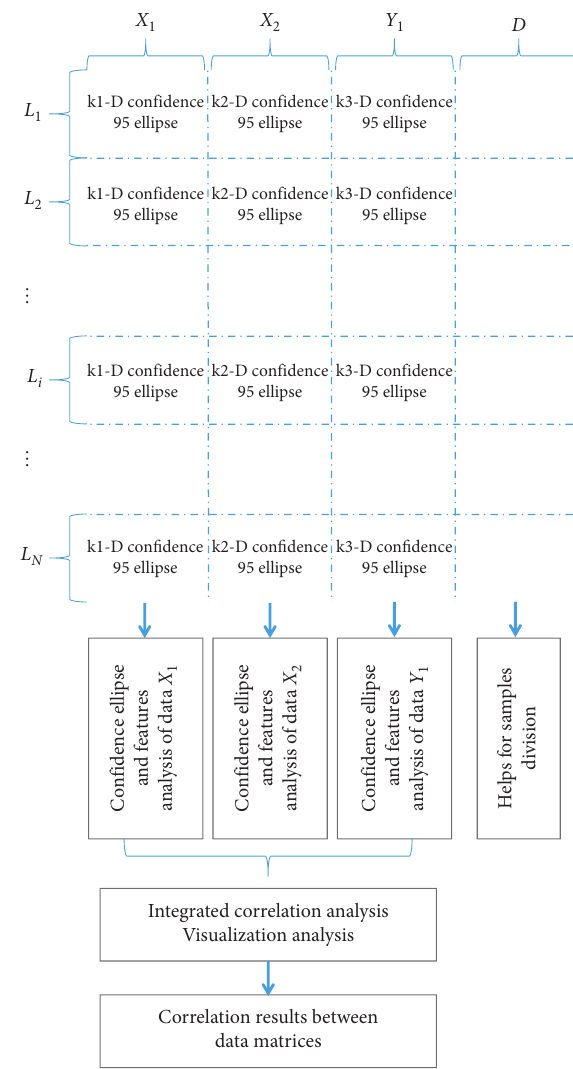
Figure 4: The specific scheme of the proposed method with the help of multidimensional confidence ellipse